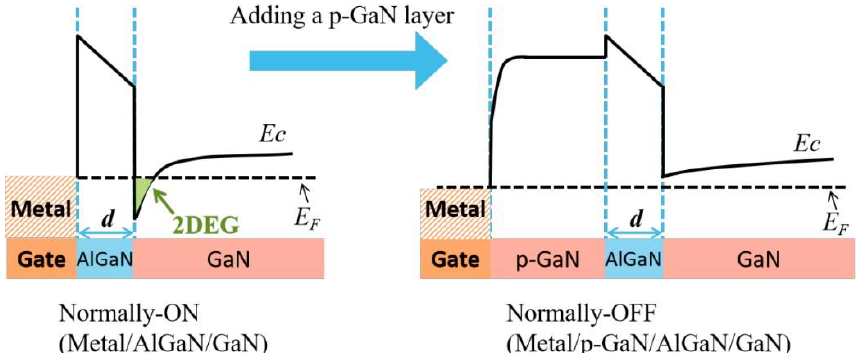
Figure 22. Metal/AlGaN/GaN energy band diagram with and without a p-GaN gate under equilib- rium. Reproduced with permission [57]. Copyright 2017, Elsevier.